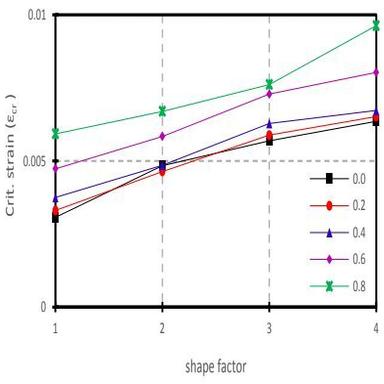
Plot of εcr vs. shf for YPT X52 pipe (D/t = 82.156).